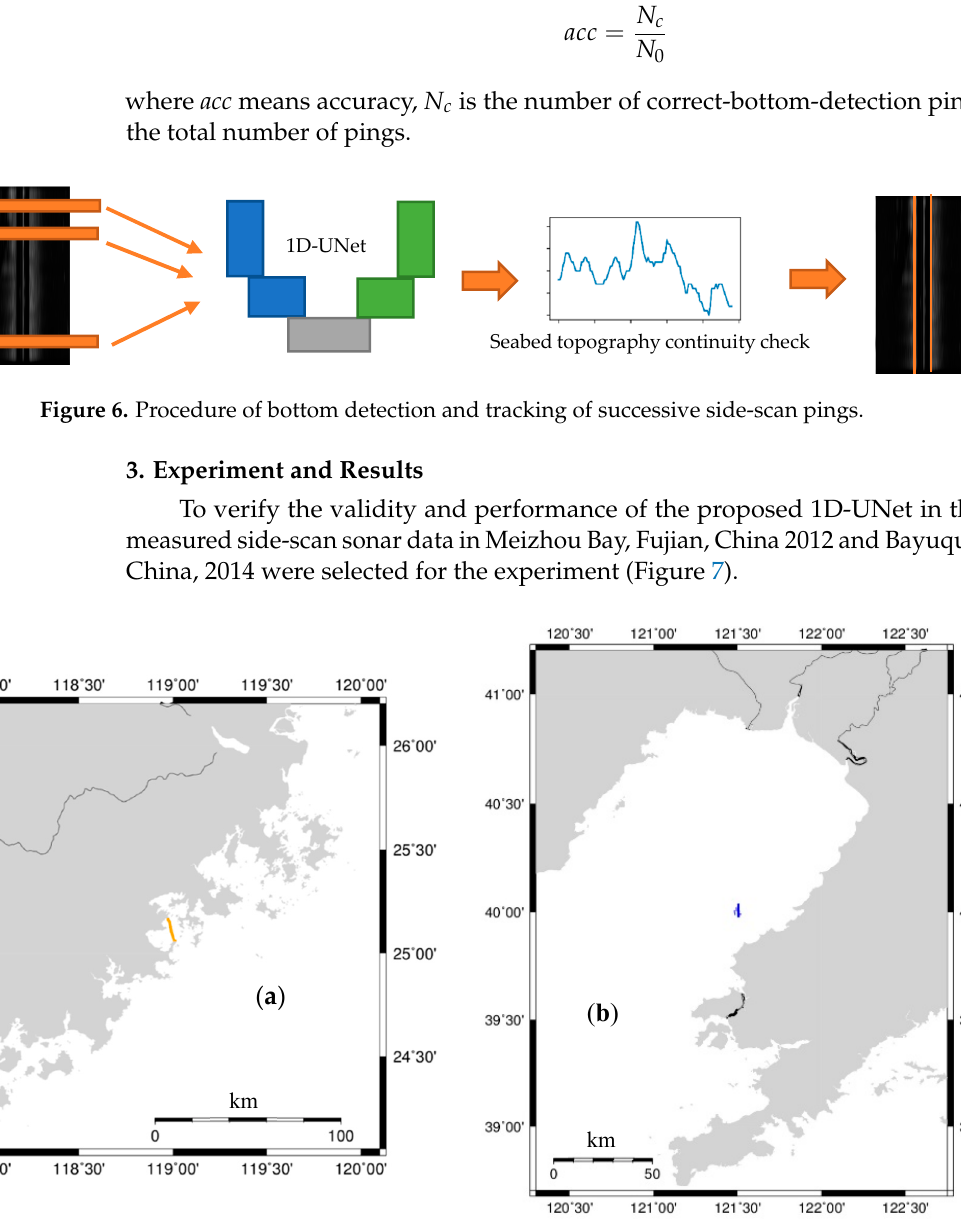
Figure 7. Experimental regions of side-scan sonar data. ( a ) is the Meizhou Bay region; ( b ) is the Bayuquan District. In Meizhou Bay, an Edgetech 4100P side-scan sonar was used for the measurement, with an operation frequency of 500 kHz, a maximum sampling slant range of 150 m, and ping interval time of 150 ms. The side-scan data in the Bayuquan District were obtained with an Edgetech 4200 side-scan sonar, with an operating frequency of 400 kHz, maxi- mum sampling slant range of 150 m, and ping interval time of 210 ms. These side-scan data were all recorded in eXtended Triton Format (*.xtf) files, which only contained the